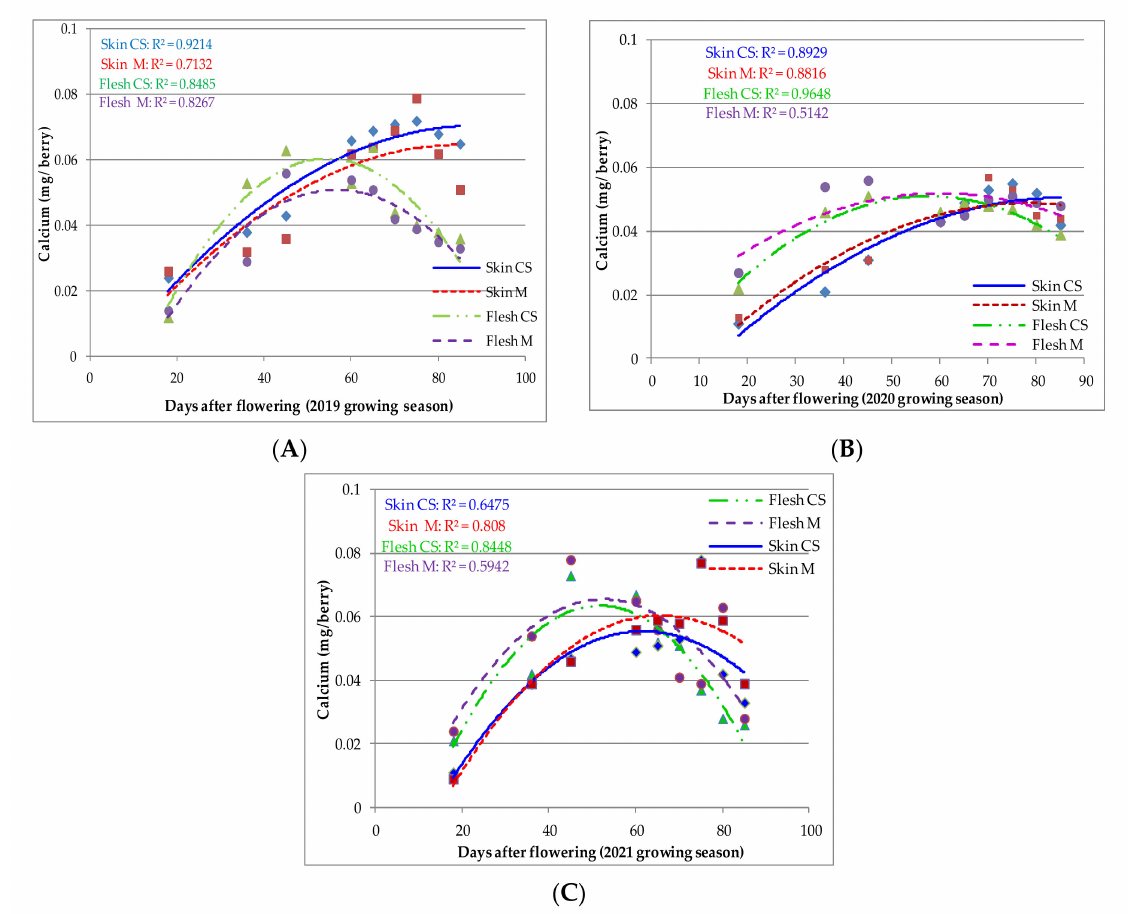
Figure 1. Ca accumulation in ‘Cabernet Sauvignon’ (CS) and ‘Merlot’ (M) berry skin and flesh during 2019–2021 growing seasons ( A – C ) from flowering to maturity. A scatterplot with a trend line of different colour and dash type was drawn to represent the relationships between DAF and Ca accumulation in flesh and skin for the CS and M varieties during 2019–2021 growing seasons. The regression analysis suggests that Ca accumulation changes with DAF. ( —Ca skin CS;